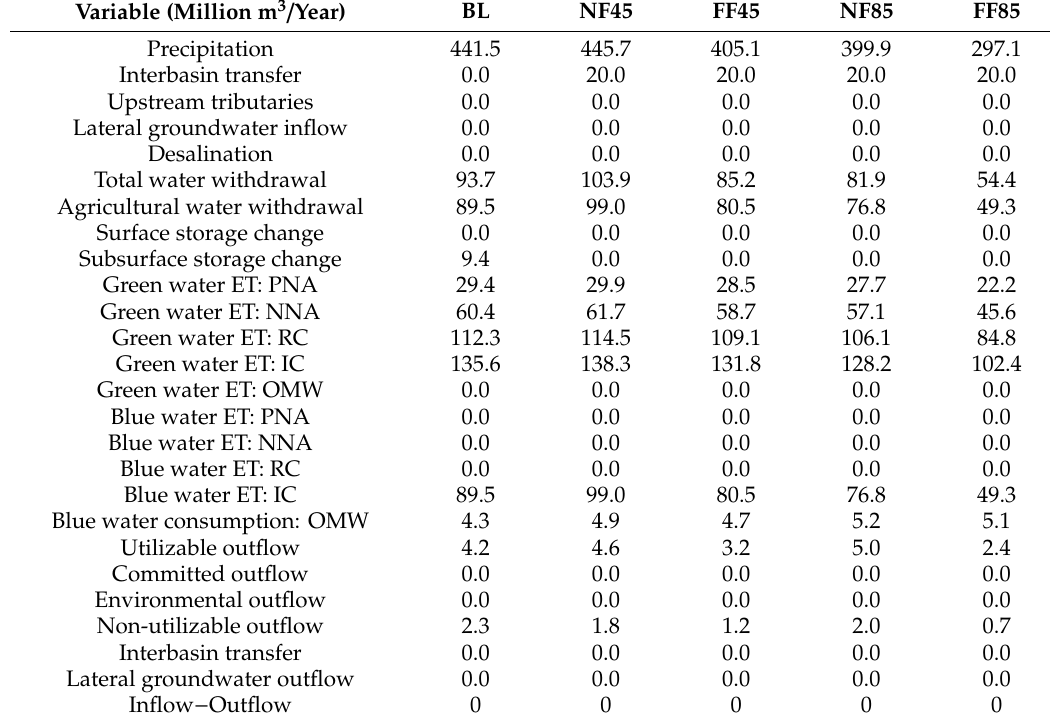
Table A4. Resource base sheet of the Messara river basin, Greece.